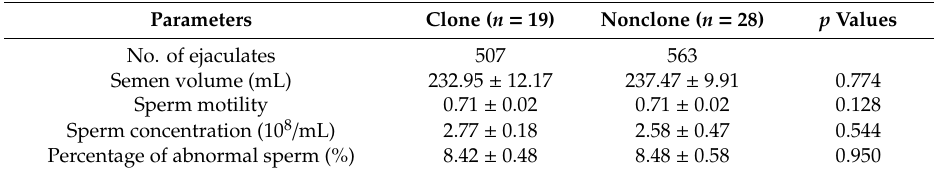
Figure 2. Growth performance of clones ( n = 12) and non-clones ( n = 36). ( a ) Adjusted days to 100 kg of body weight. ( b ) Average daily gain between adjusted 30 kg to 100 kg of body weight; ( c ) Backfat thickness adjusted to 100 kg of body weight; ( d ) Body length. ( e ) Body height. * stands for p ≤ 0.05, ** stands for p ≤ 0.01, *** stands for p ≤ 0.001. ns stands for nonsignificant di ff erences. Table 2. Semen quality of cloned and non-cloned Pietrain boars.